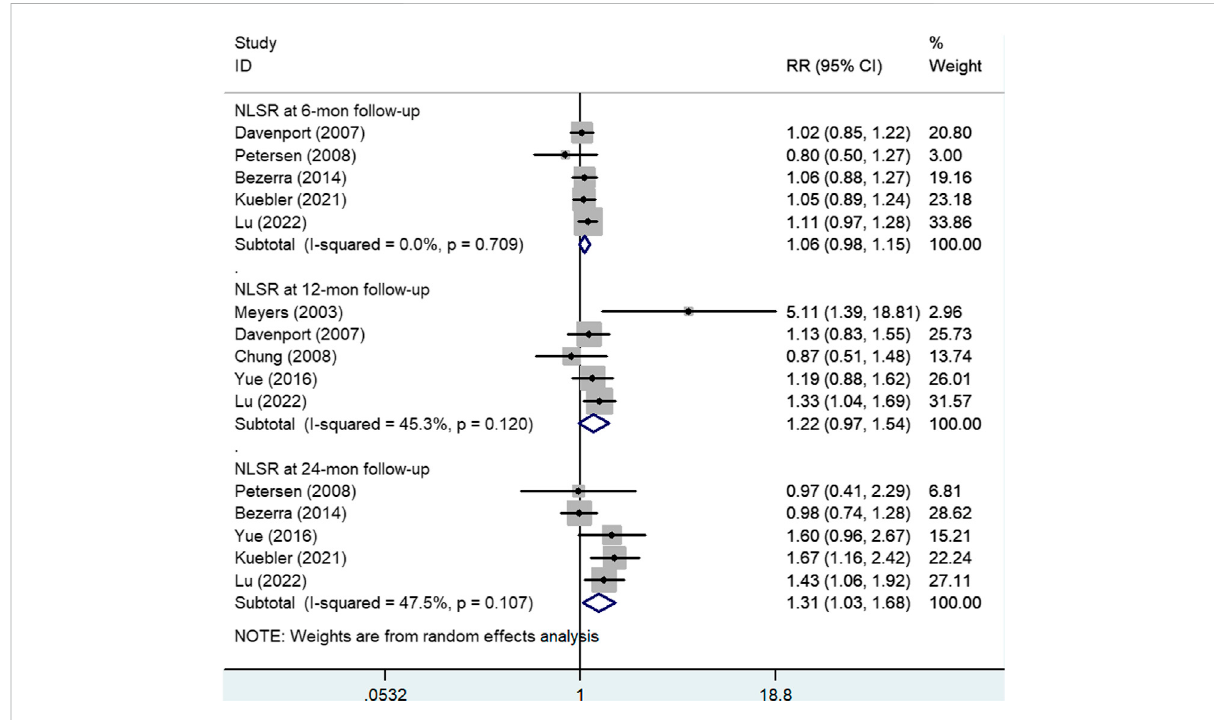
FIGURE 5 Forest plot for NLSR at 6, 12, and 24 months of steroid vs. non-steroid group. NLSR, native liver survival rate.